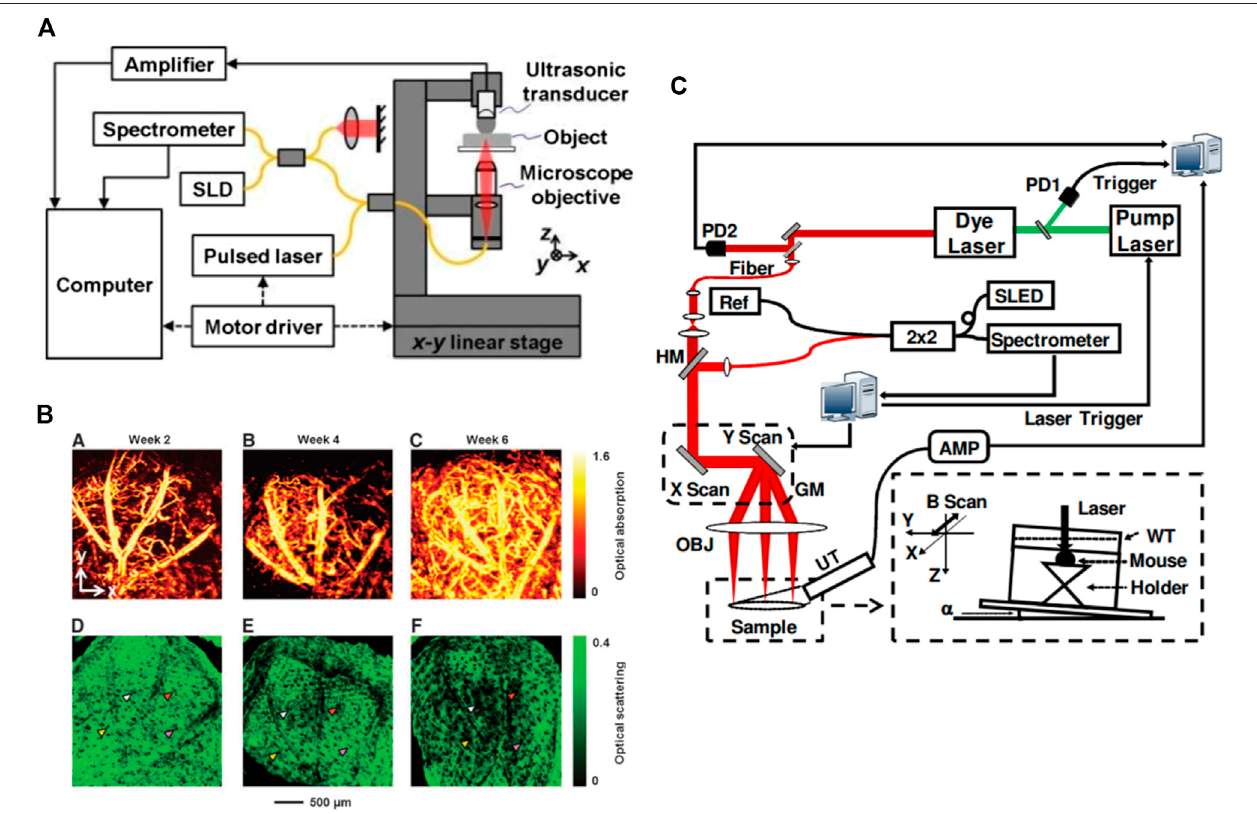
FIGURE 3 | (A) Schematic of the combined PAM-OCT. SLD: superluminescent diode. Solid lines represent single-mode optical fi bers. Reprinted with permission from [113]; (B) PAM and OCT images showing the vasculature and tissue structure for an inverse scaffold with a pore size of 200 μ m; (A – C) PAM images showing the development of blood vessels at 2, 4, and 6 weeks after implantation, respectively; (D – F) the corresponding OCT images showing the tissue structure. Reprinted with permission from [114]; (C) schematics of the combined PAM and OCT. PD: photodiode; HM: hot mirror; GM: 2D galvanometer; OBJ: objective lens; AMP: ampli fi er; UT: ultrasonic transducer; WT: water tank; SLED: superluminescent emitting diode; Ref: OCT reference arm. Reprinted with permission from